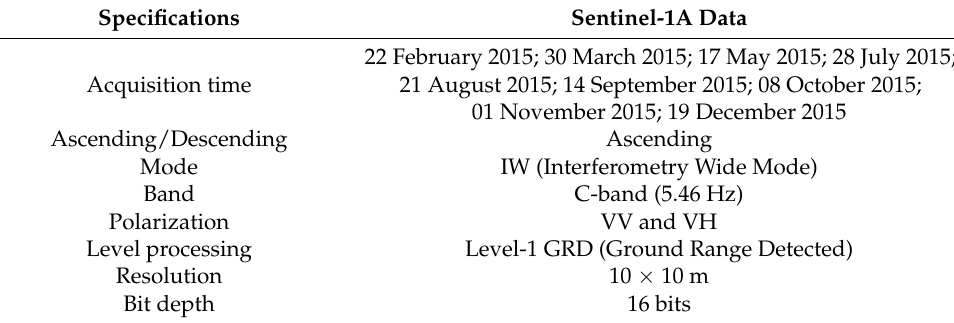
Table 2. Multitemporal Sentinel-1A data used in this